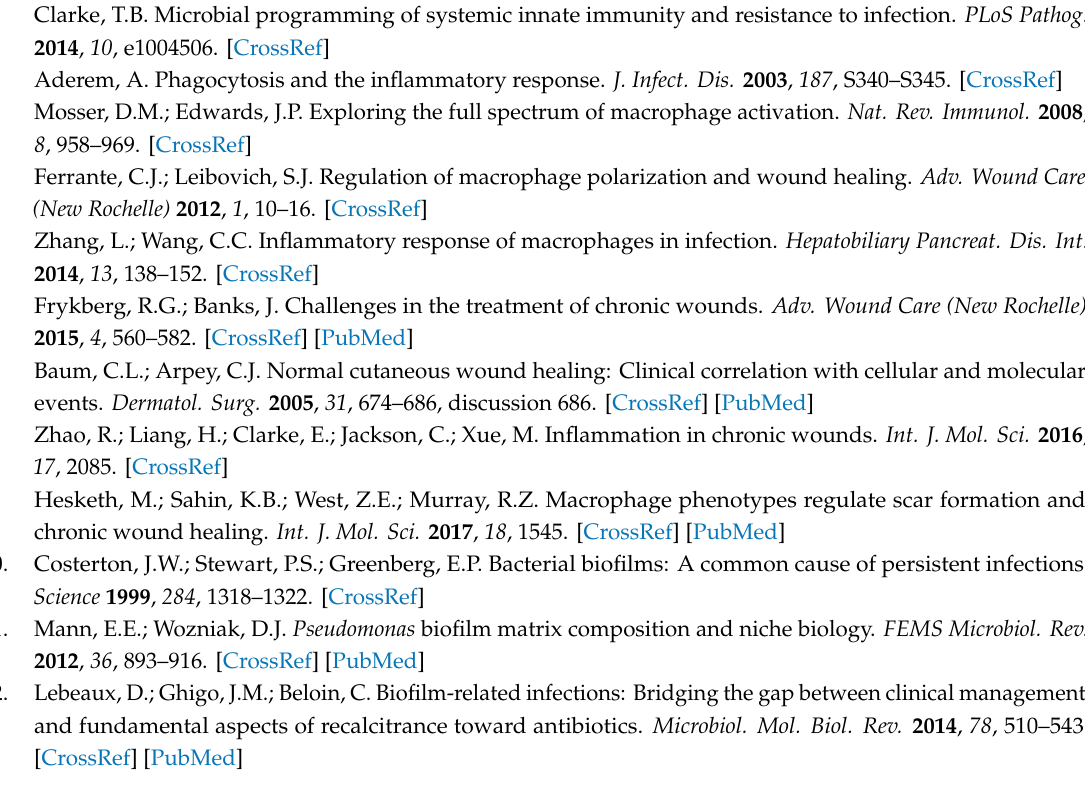
spectrometer on extracellular metabolite extracts from M Φ s; Figure S7: PCA loadings plot for (A) intra- and (B) extracellular M Φ metabolite extracts; Figure S8: BCM- and PCM-exposed M Φ s share common metabolic trends relative to control M Φ s; File S1: Intracellular PCA loadings; File S2: Extracellular PCA loadings; Table S1: Comparison of select metabolite concentrations in di ff erent exposure group sham media controls; Table S2: Summary of unique metabolite species, by class, identified using 1D 1 H-NMR; Table S3: Metabolite detection across all samples; Table S4: 1D 1 H-NMR intra- and extracellular metabolite limit of detection (LOD)